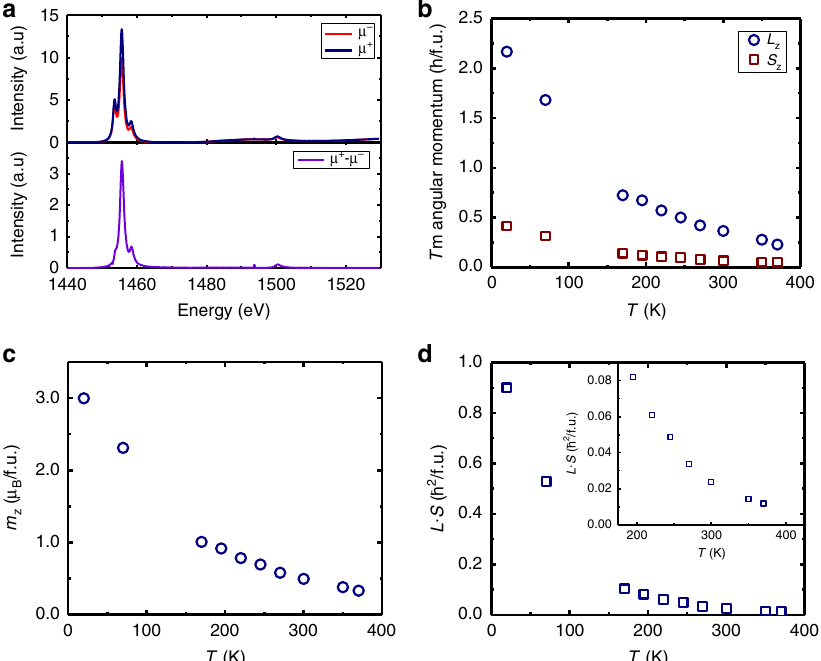
Fig. 5 X-ray magnetic circular dichroism on GGG/TmIG (6.0 nm). a Exemplary Tm XMCD spectrum under 10 kOe fi eld at T = 70 K showing positive ( μ + ) and negative ( μ − ) helicity and a difference spectrum ( μ + – μ − ). z -component of the b orbital ( L z ) and spin ( S z ) angular momentum and c magnetization m z as a function of temperature ( T ). d Temperature dependence of spin – orbit coupling ( L (cid:5) S ). The inset in d expands the data between 200 and 400 K for clarity. The error bars in b – d are smaller than the data points and represent standard errors estimated from a variation of the sum rule integration boundaries. In addition, there is a systematic measurement uncertainty of 20% on the absolute scale. a.u., arbitrary units. f.u., formula unit.